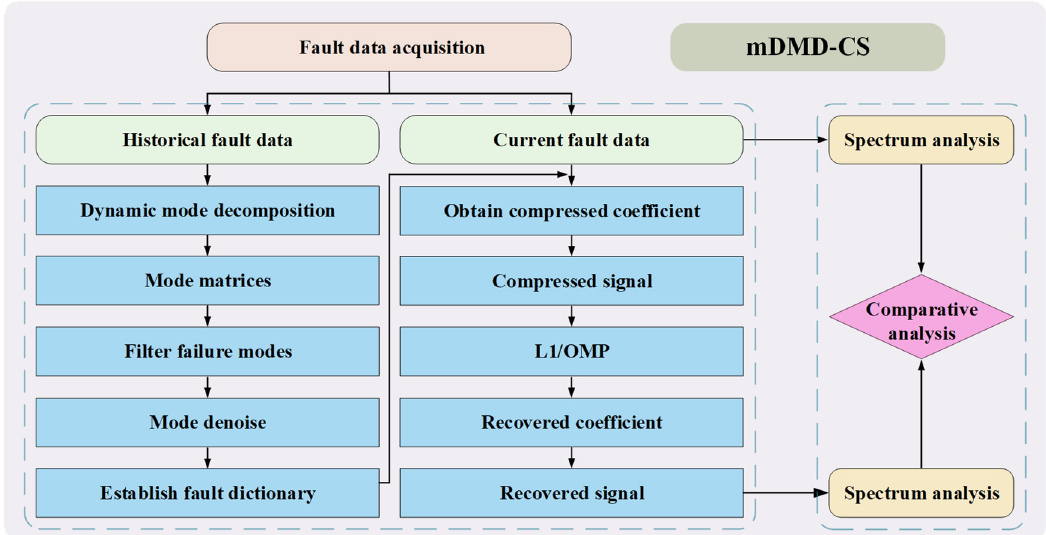
Figure 4. The schematic diagram of compressed sensing, based on adaptive dynamic mode decom- Figure 4. Theschematicdiagramofcompressedsensing, position.